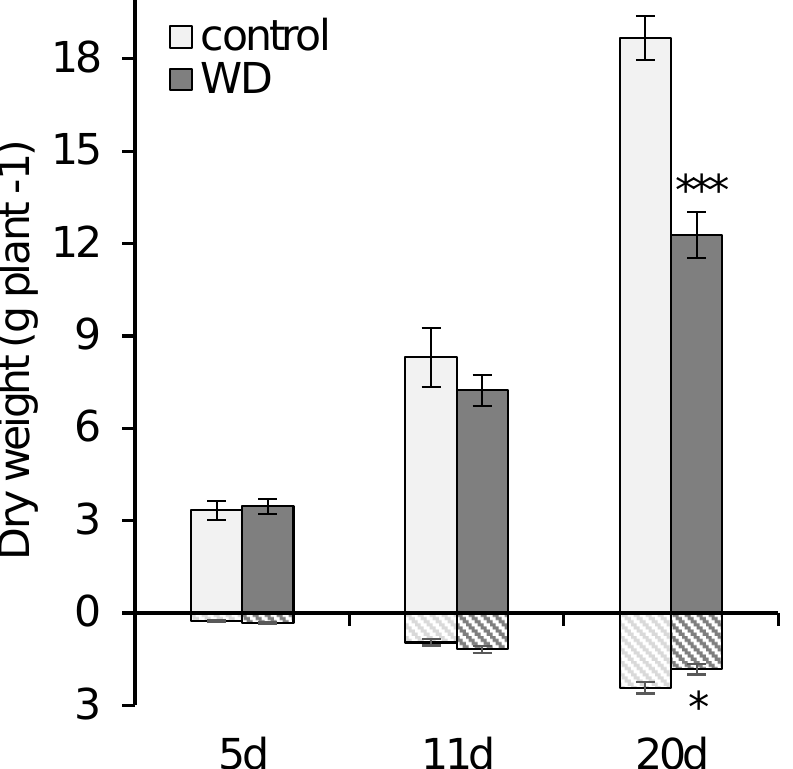
Figure 1. Shoot (plain) and root (hatch) biomasses of B. napus exposed for 5 d (mild), 11 d (severe), and 20 d (severe and extended) of water deficits (WD). Data are given as the mean ± SE ( n = 5), and significant differences between control and plants exposed to WD are indicated as follows: *: p < 0.05; ***: p < 0.001.